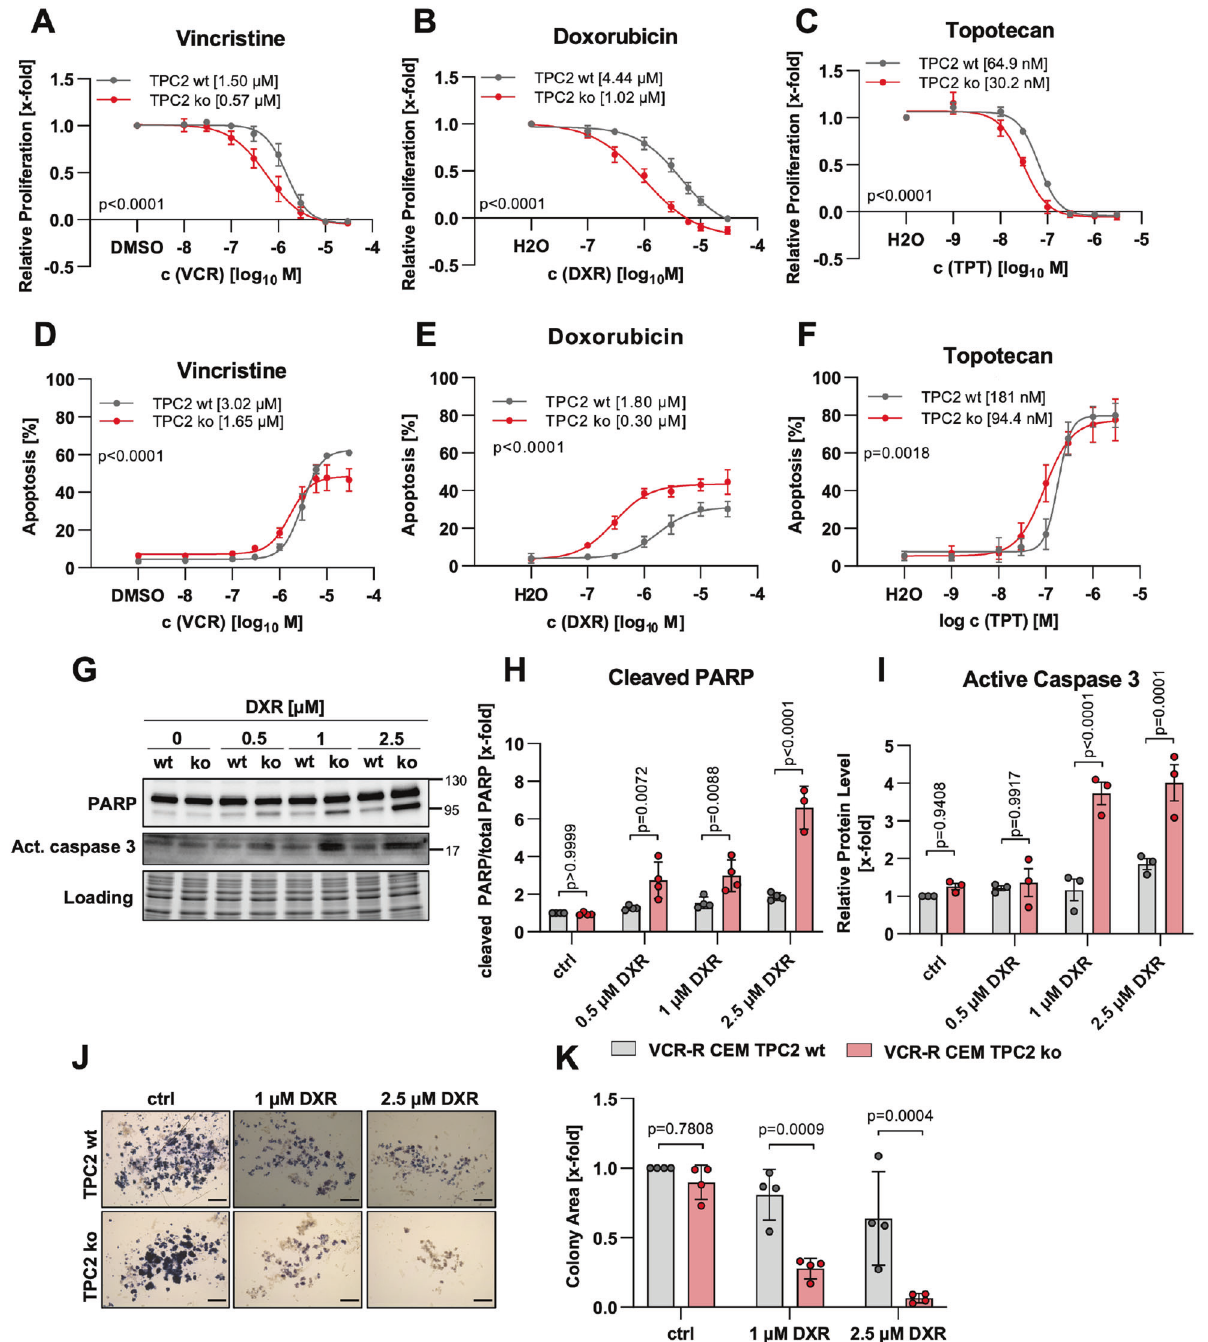
Fig. 2 TPC2 knockout sensitizes VCR-R CEM cells to treatment with cytostatics. VCR-R CEM TPC2 wt and TPC2 ko cells were treated for 72 h ( A – C ) or 48 h ( D – F ). The antiproliferative effect of ( A ) vincristine, ( B ) doxorubicin, and ( C ) topotecan was assessed by CellTiter-Blue assay. Apoptosis induction after ( D ) vincristine, ( E ) doxorubicin and ( F ) topotecan treatment was assessed by propodium iodide staining and fl ow cytometry. G Immunoblots of VCR-R CEM wt and TPC2 ko cells. H , I Quantitative evaluation of protein levels from ( G ). J Cells were treated as indicated for 4 h and re-seeded in medium with 40% FCS and 0.4% methylcellulose and allowed to form colonies over 5 days of incubation. Living cells were stained with MTT reagent and images were analyzed in ImageJ (scale bar is 200 µm). Note that for evaluation color threshold of images was modi fi ed. K Quantitative evaluation of relative colony area of J . Data were acquired from at least three independent experiments. Statistical signi fi cance was analyzed using the comparison of fi ts function of GraphPad Prism 8, comparing logIC50 or logEC50 values ( A – F ) or two-way ANOVA with Sidak ’ s posttest ( H , I , K ). Data are shown as mean ±